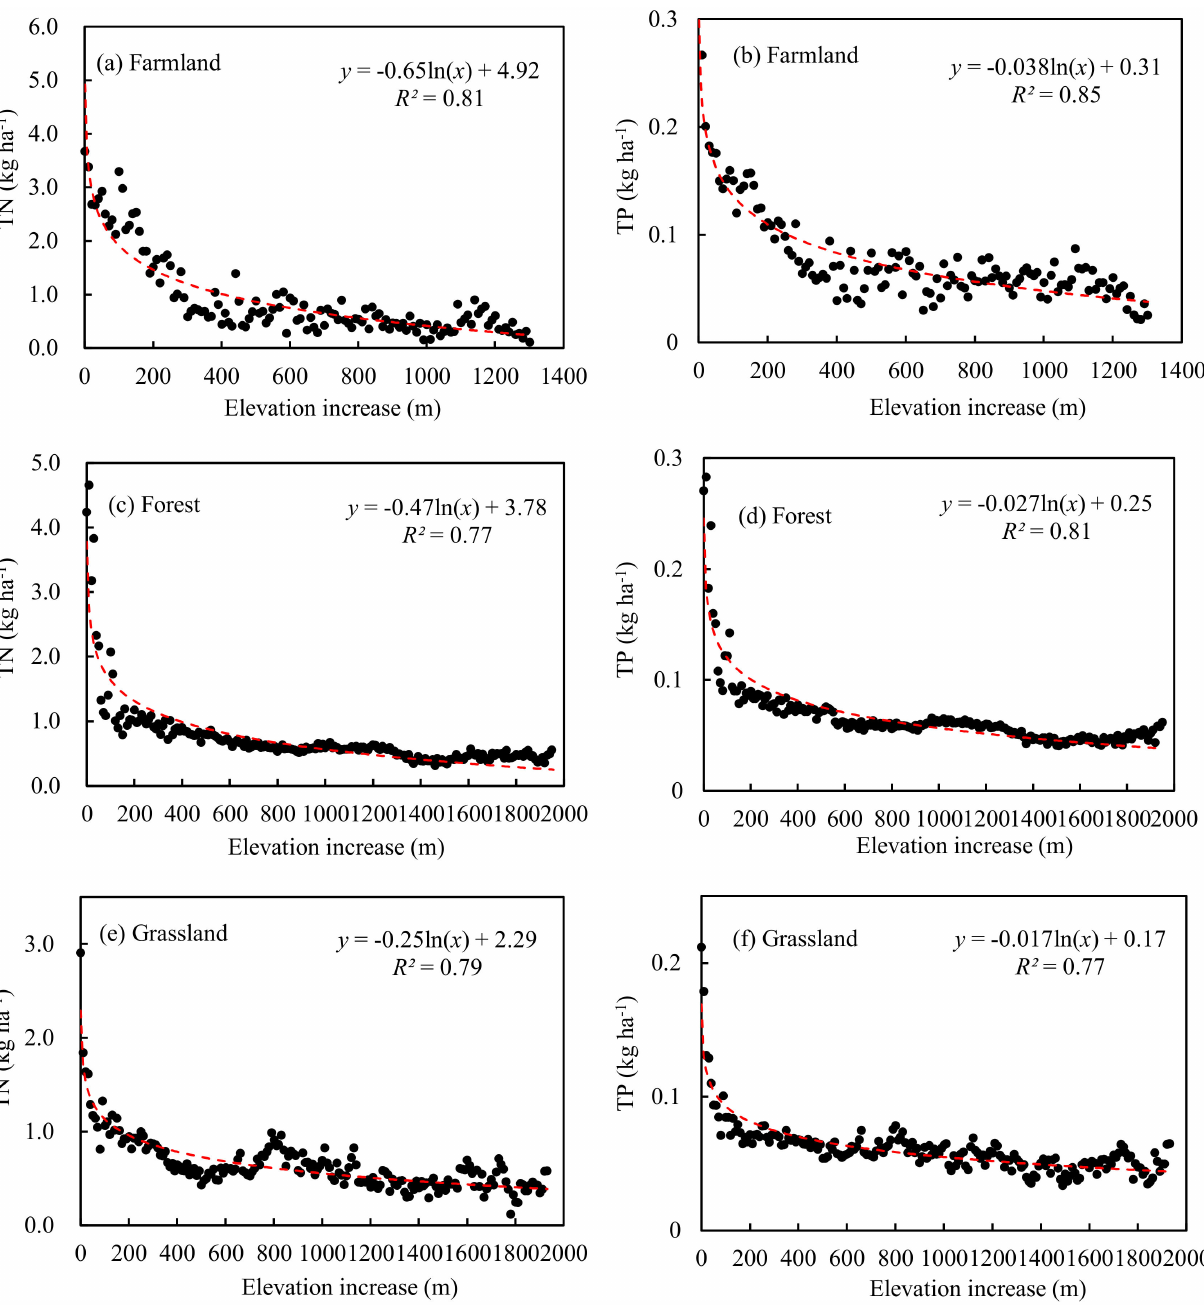
Figure 14. Variation characteristics of pollution load intensity at different elevations under a single land use type: TN for farmland ( a ), forest ( c ) and grassland ( e ), TP for farmland ( b ), forest ( d ) and grassland ( f